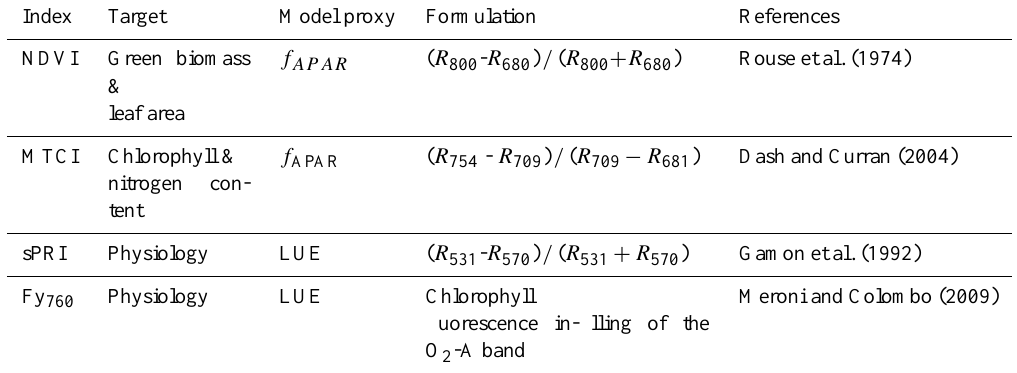
Table 2. Spectral vegetation indices computed in this study. Vegetation indices are classified into two major classes based on their suitability in inferring f APAR (structural related indices) and LUE (physiologically related indices) parameters. R denotes the reflectance at the specified wavelength (nm). NDVI: normalized difference vegetation index; MTCI: MERIS terrestrial-chlorophyll index; NDI: